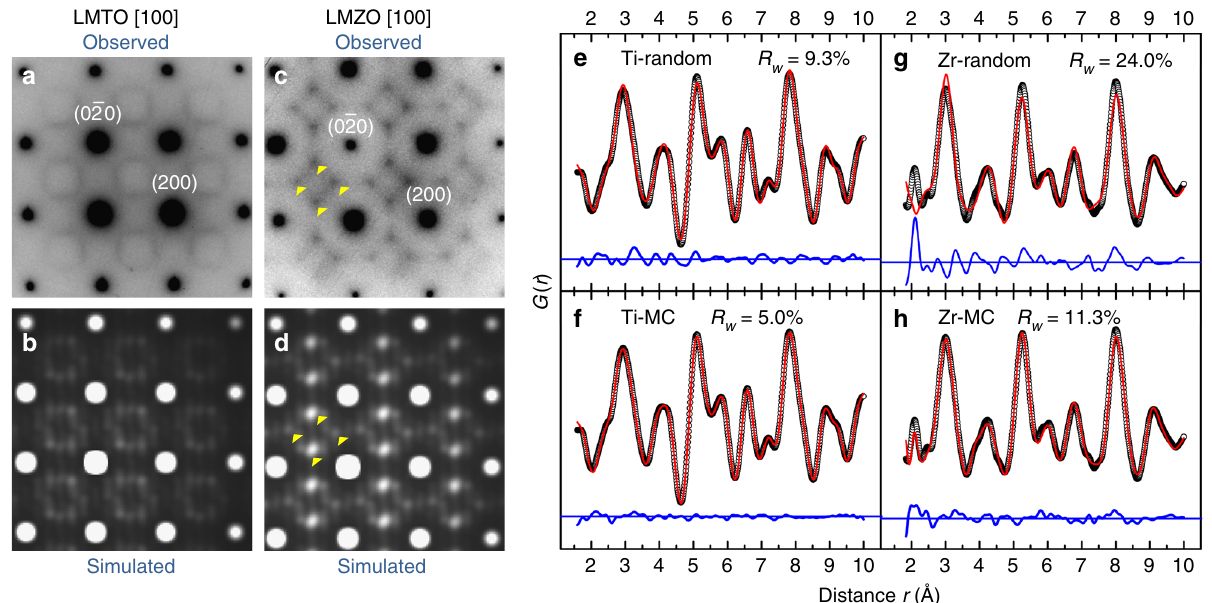
Fig. 3 Experimental observation and computational simulation of short-range order (SRO) in LMTO and LMZO. ED patterns of LMTO ( a ) and LMZO ( c ) along the zone axis [100]. The round spots are indexed to the F m – 3 m space group, while the diffuse scattering patterns nearby are attributed to SRO. Several intensity maxima in the diffuse scattering patterns are highlighted with yellow arrows in LMZO. Simulation of ED patterns for LMTO ( b ) and LMZO ( d ) along the same zone axis shows good agreement with experimental observation. Re fi nement of NPDF data of LMTO ( e , f ) and LMZO ( g , h ) using the random model ( e , g ) and MC-equilibrated structural models ( f , h ). The experimental data are plotted as black open circles. The calculated values are plotted as solid red lines. The difference between observation and calculation is plotted as solid blue